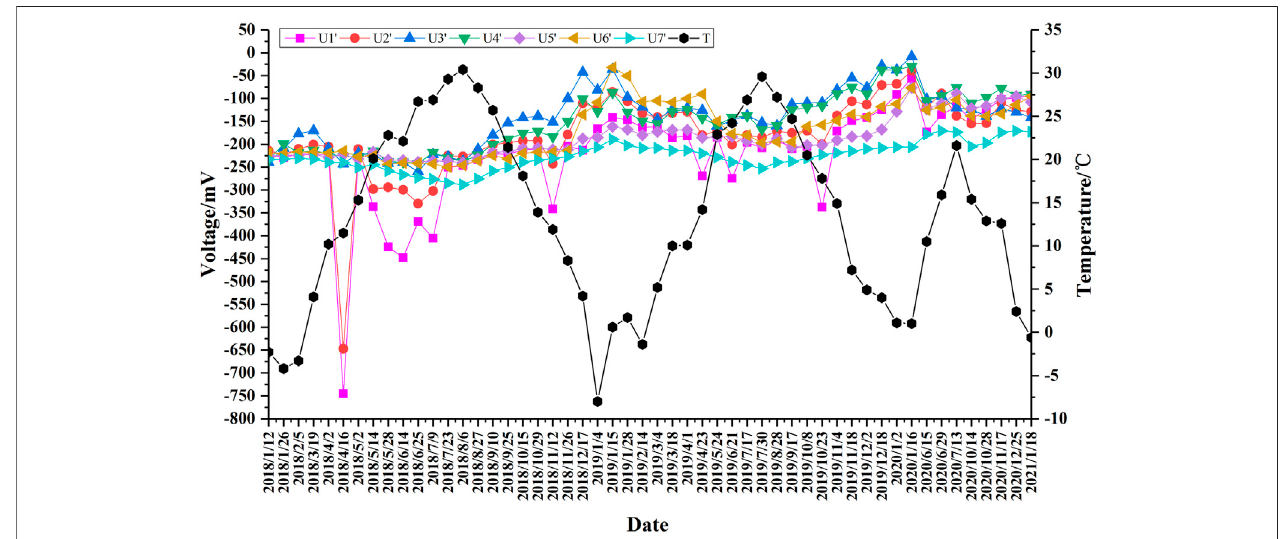
FIGURE 9 | Voltage between anode and reference